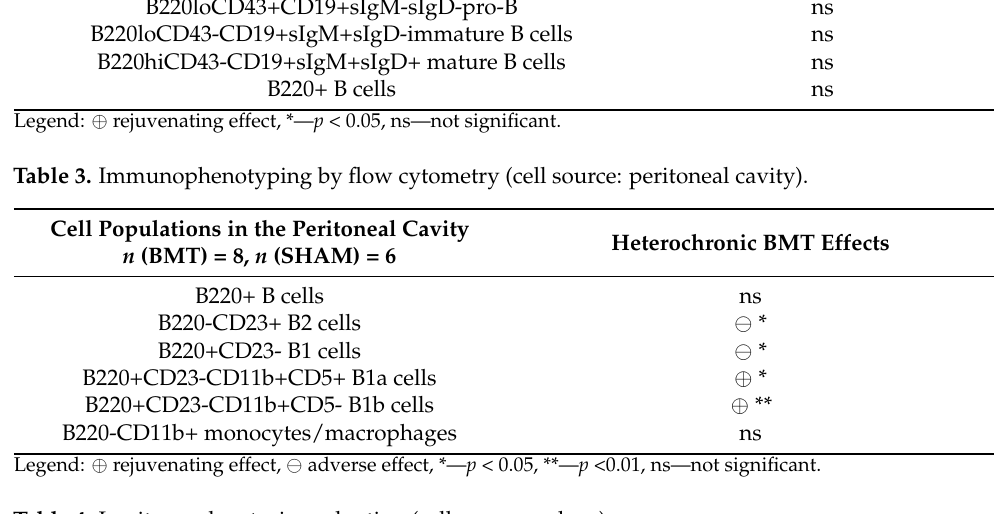
Table 4. In vitro endocytosis evaluation (cell source: